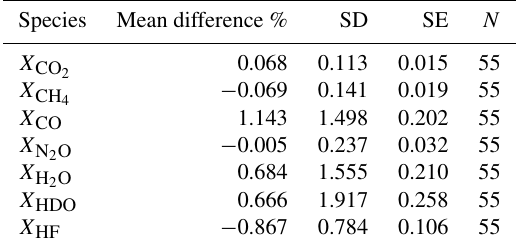
Table 5. Comparison of retrievals from both instruments. Mean dif- ference (IFS 120HR minus IFS 125HR) of daily mean values, their SD and standard error (SD of the sample mean) expressed as a per- centage, and the number of daily means compared.